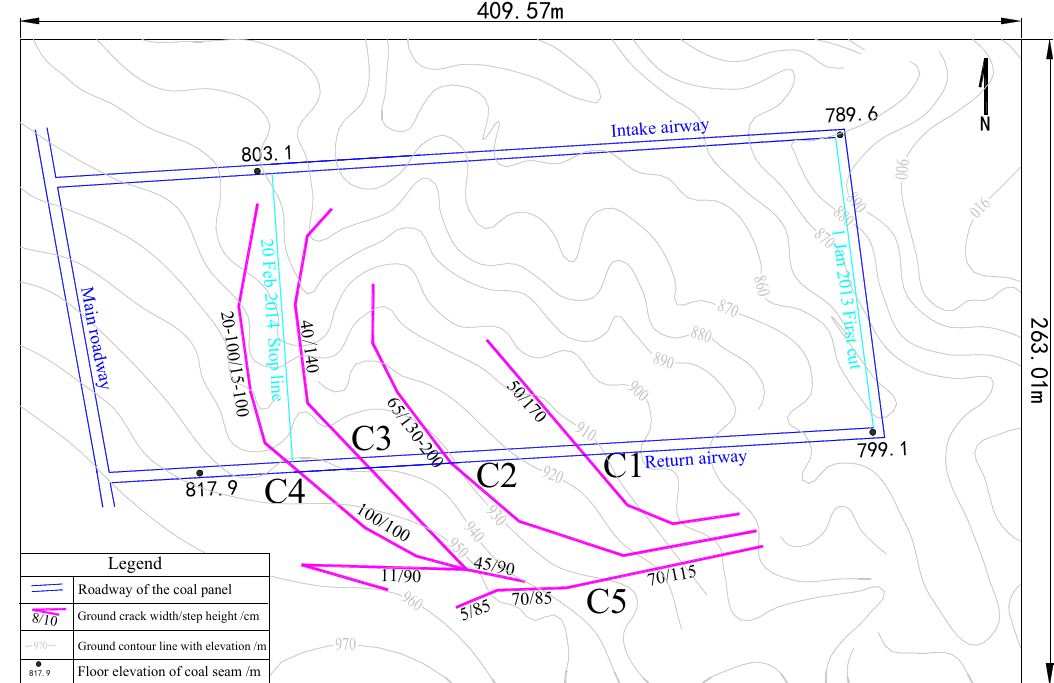
Figure 2. Position relationship between surface cracks and topography, with working face. Appl. Sci. 2020 , 10 , x FOR PEER REVIEW